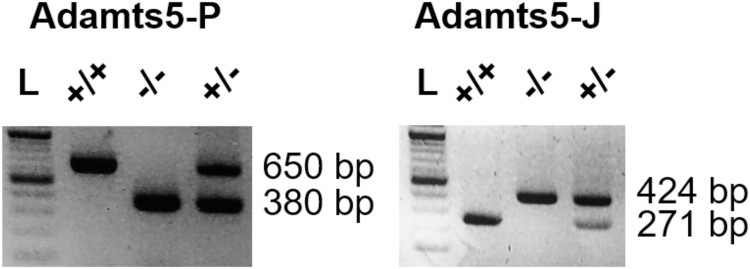
Characterization of ADAMTS5-P and ADAMTS5-J mice.Genotyping of wild-type (+/+), heterozygous (+/-) and homozygous (-/-) deficient ADAMTS5-P and ADAMTS5-J mice. L represents the basepair (bp) ladder. ADAMTS5, a disintegrin and metalloproteinase with thrombospondin type 1 motifs member 5.